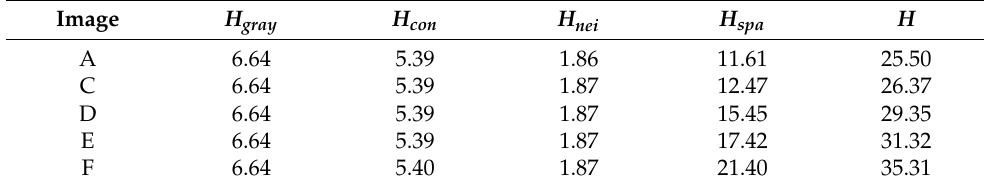
Figure 12. Information content of the original image and its simulated image. Table 2. Information content results of the original and simulated image (bit/pixel).